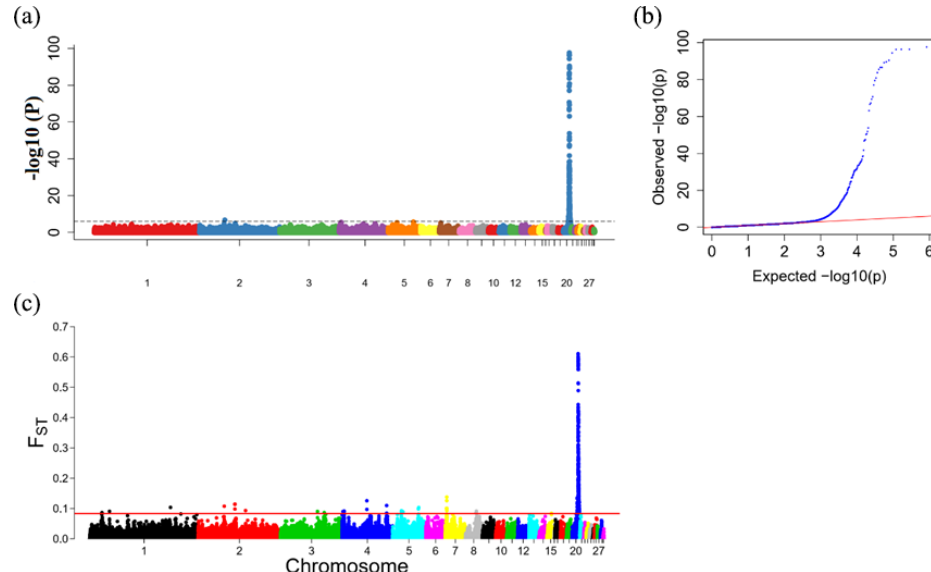
Figure 3. Results from the genome-wide association study (GWAS) of face color phenotype. (a) Manhattan plot of the GWAS for the face color phenotype; the y axis shows − log10( P ) values adjusted by a Bonferroni approach for the association tests, and the dashed horizontal line indicates the genome-wide significant threshold value ( − log10( P ) > 6). (b) The quantile–quantile plot of the P values; the x axis shows the expected − log10( P ) values, and the y axis shows the observed − log10( P ) values. (c) Genome-wide distribution of F ST values for pairwise comparison of dark-faced vs. white-faced layers. The solid red line represents the threshold of significance (top 0.1% SNPs).